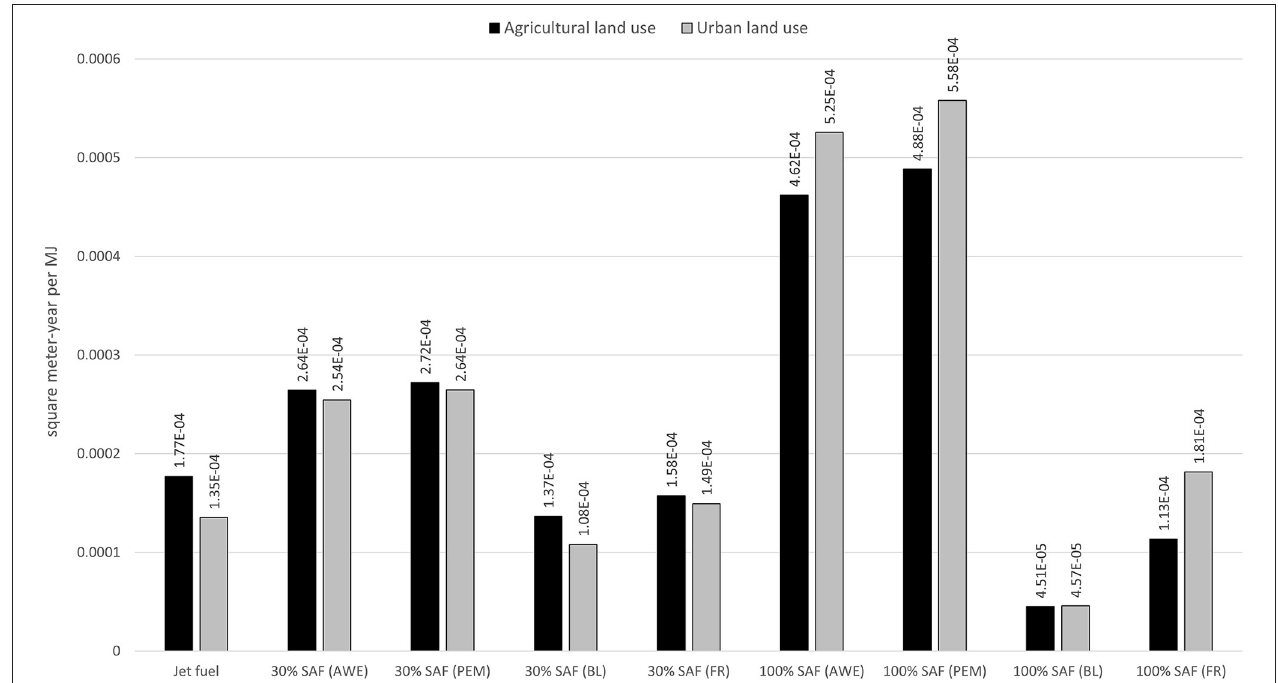
FIGURE 9 | Well-to-pump agricultural and urban land use per 1 MJ of jet fuel, 30% SAF and 100% SAF in 2030.